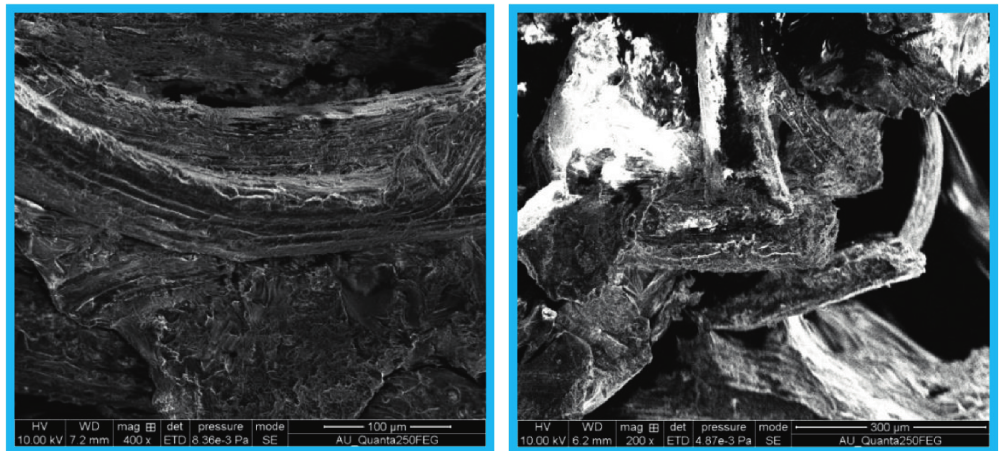
Figure 6: Effect of fiber parameters on the surface roughness test.